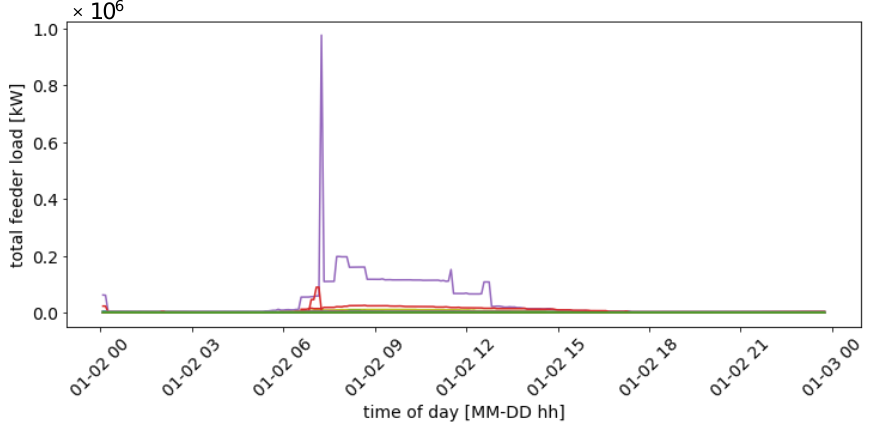
Figure 7. Scenario 2 feeder loads with EV charging.